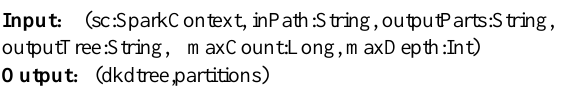
Algorithm 1 the Parallel Construction of DKD-Tree on